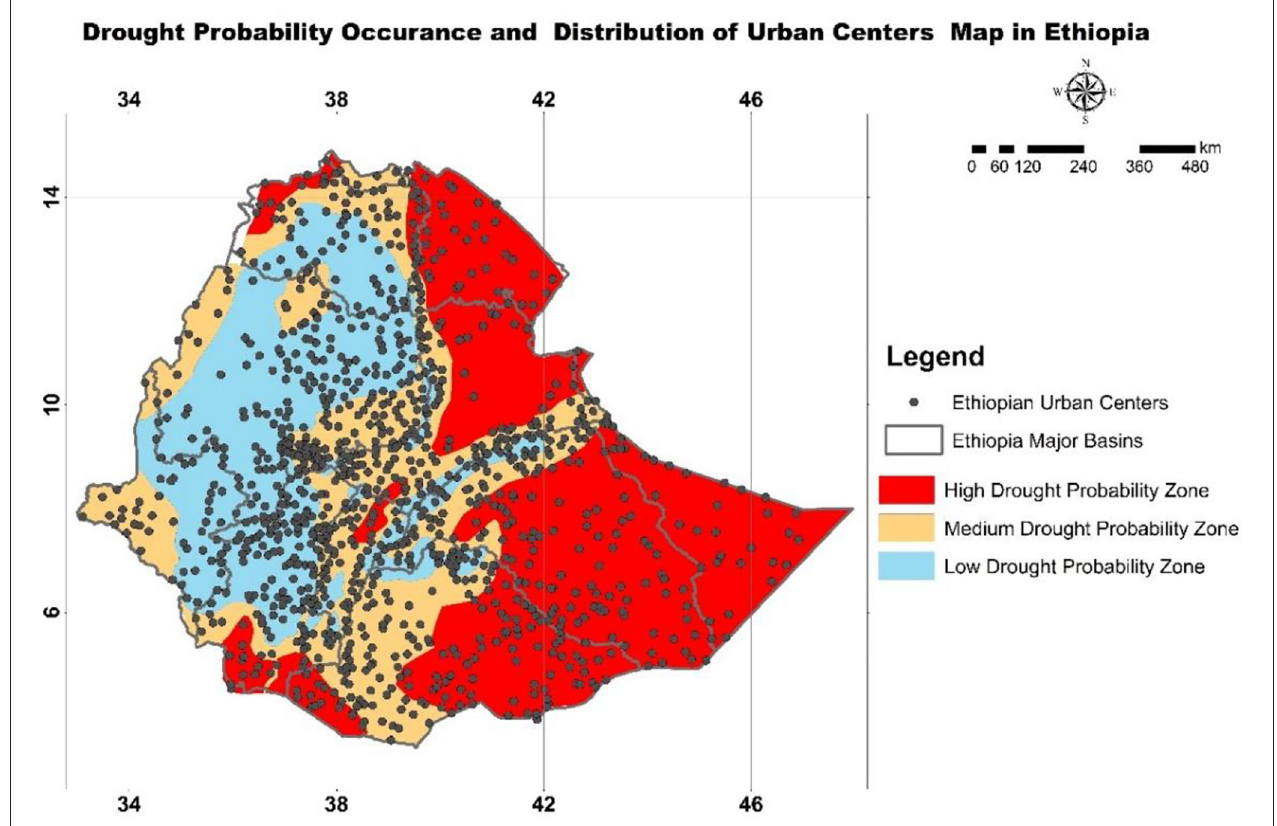
FIGURE 7 | A drought probability map of Ethiopia and location of urban centers. Source: A drought probability map adopted from Ministry of Water Resources National Meteorological Agency (2007) . scarcity occurs when annual water availability falls below 500 m 3